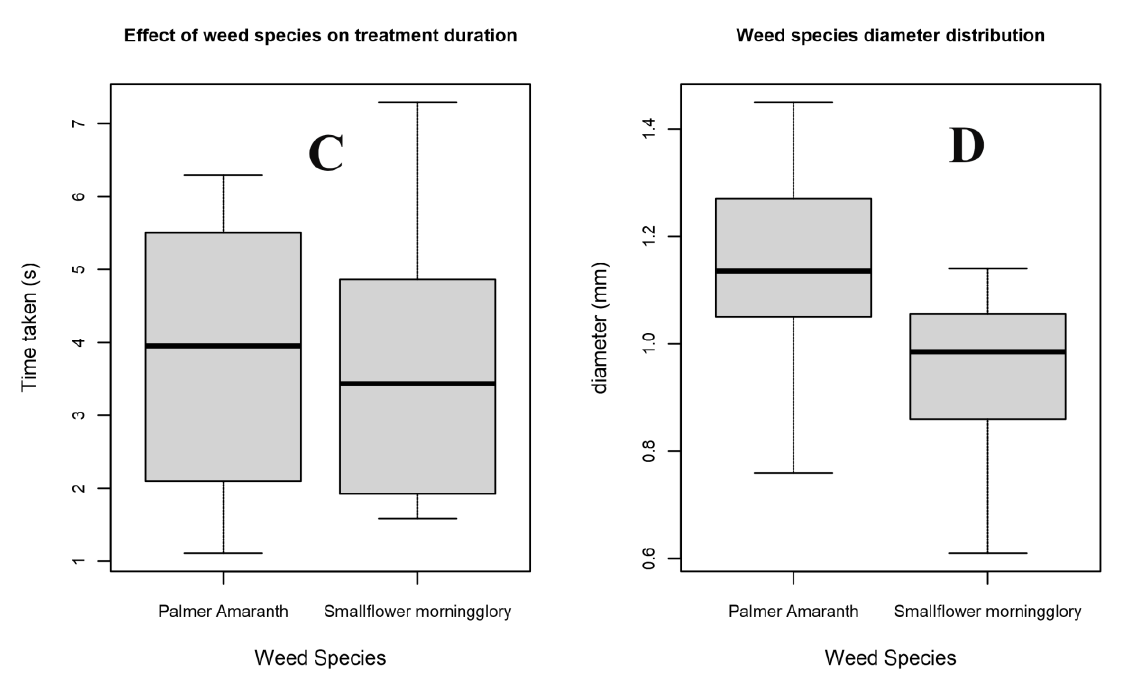
Figure 6. Box and whisker plots of the time taken to cut the weed stem vs. three factors, and the diameter data for each weed species. ( A ) shows the laser power effect where the error bars for first class (1.2 and 1.35W) lasers overlap significantly, likely, the second class (4.2 and 4.5W) lasers overlap, while the two classes not overlapping, hence the statistical significant difference between the classes while no difference within classes, ( B ) shows the effect of distance between laser diode and weed stem where the error bars overlap more between 5 and 10cm with less overlap at 15cm which caused the statistical difference, ( C ) represents the effect of species where the error bars overlap with no statistical difference, and ( D ) represents the diameters data for each weed species with palmer amaranth having slightly higher average diameter than smallflower morningglory.